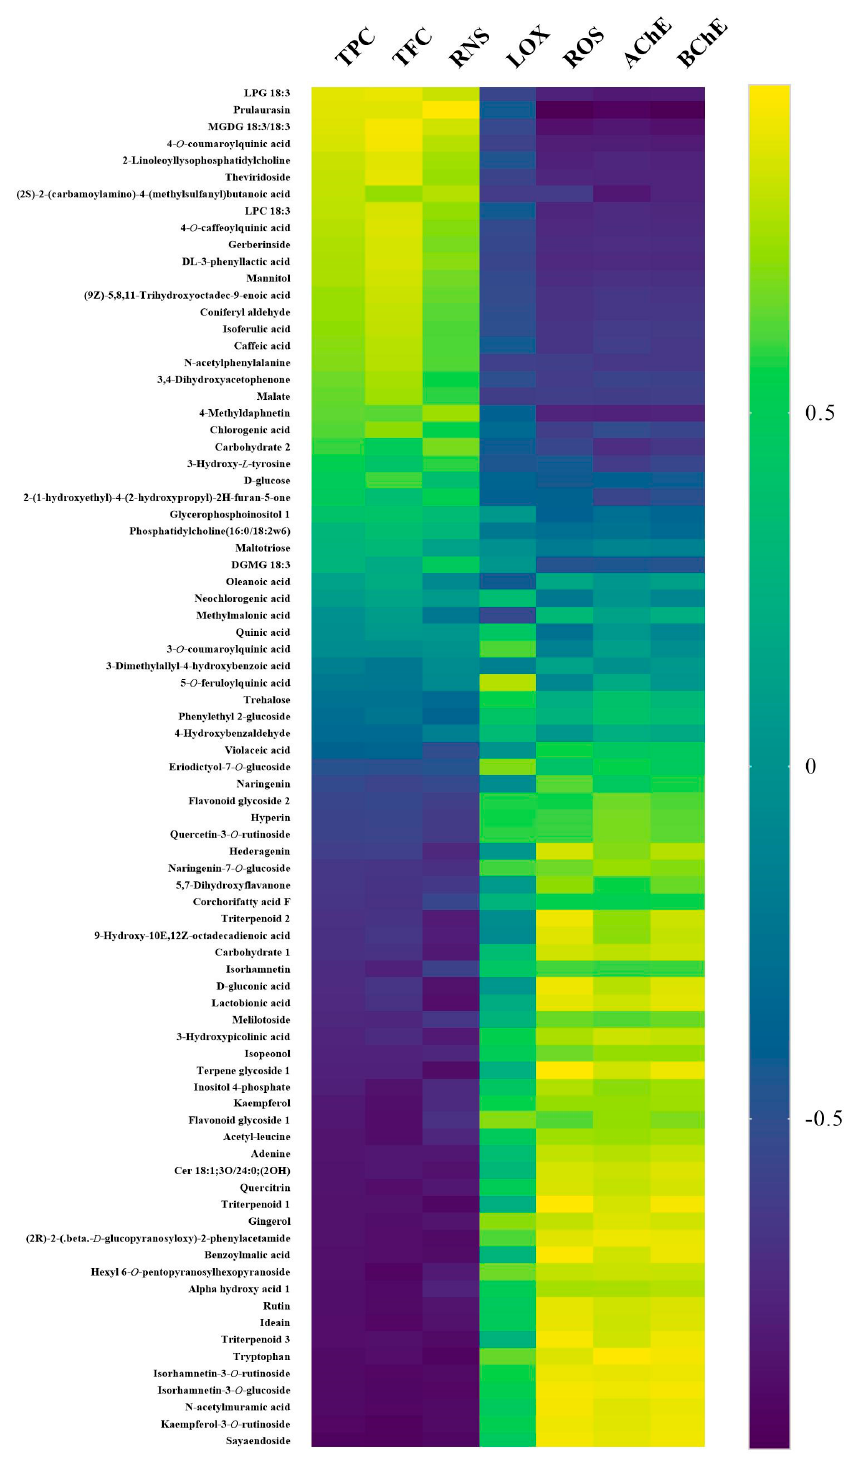
Figure 2. HeatMap of the correlations between metabolites and the neuroprotective potential.